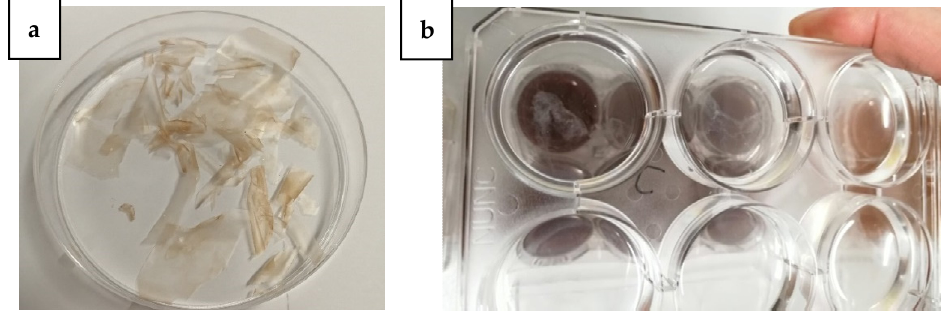
Figure 1. Excluding a ( a ) carbon or ( b ) nitrogen source from HS media either produces BC film that is too brittle to analyze or does not produce BC at all.